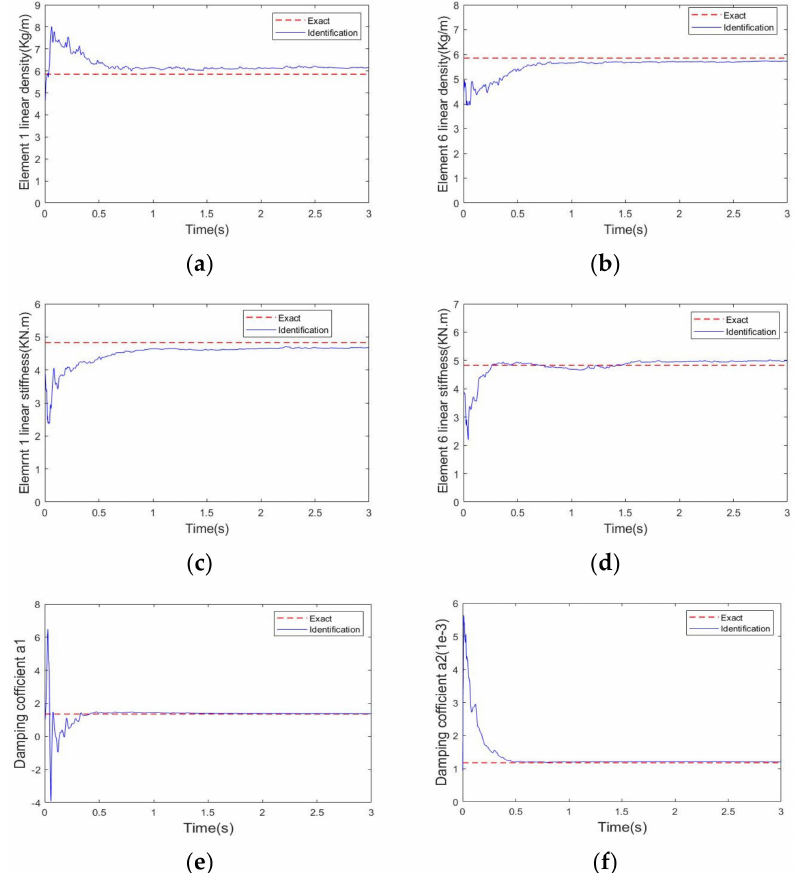
Figure 3. Parameter estimation results for the simply supported beam. ( a ) Convergence of identified linear density; ( b ) convergence of identified linear density; ( c ) convergence of identified linear stiffness k 1 ; ( d ) convergence of identified linear stiffness k 6 ; ( e ) convergence of identified damping coefficient a 1 ; ( f ) convergence of identified damping coefficient a 2 .